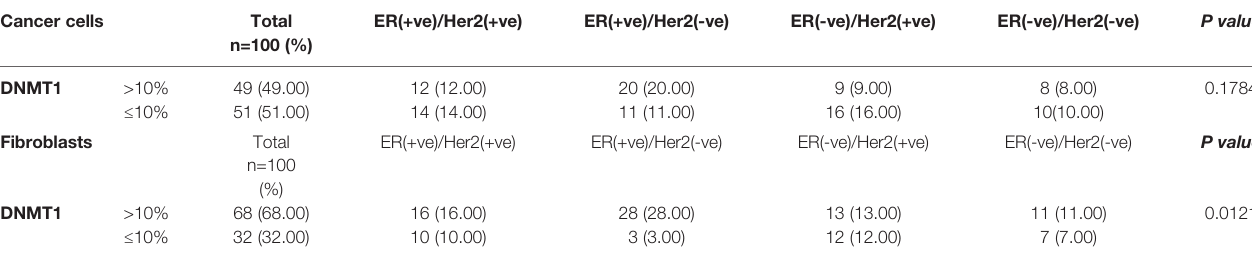
TABLE 2 | Expression of DNMT1 in cancer cells and stromal fi broblasts by breast cancer ER/Her2 subtypes. Cancer